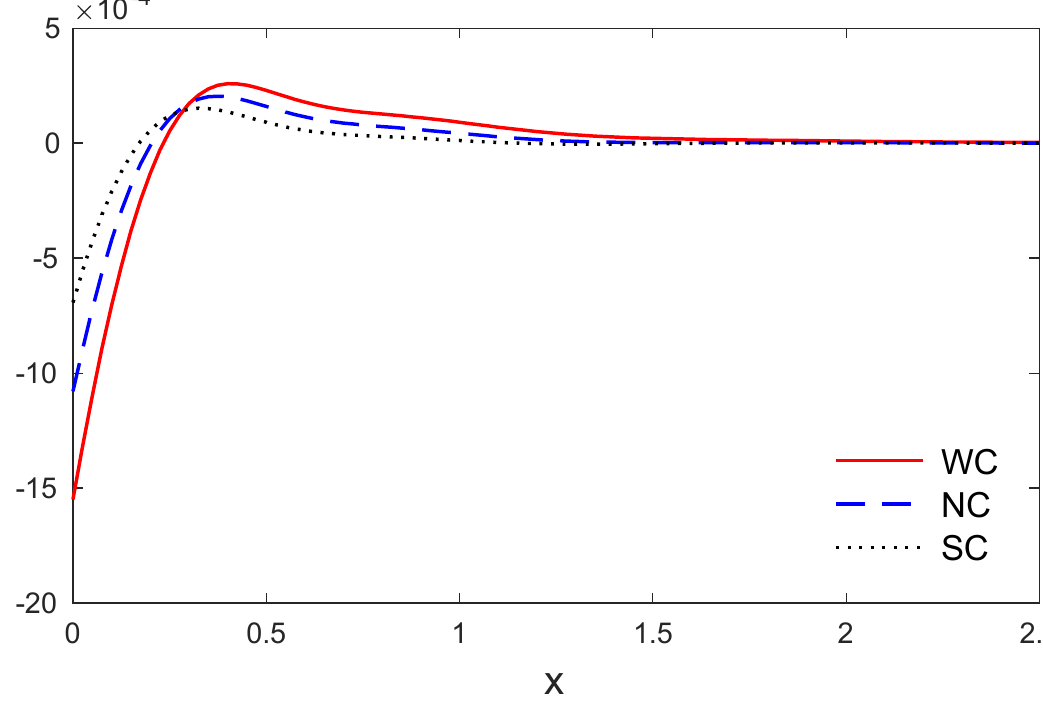
Figure 4. The variations of horizontal displacement u via x with y = 0.4 for strong normal and weak conductivities.